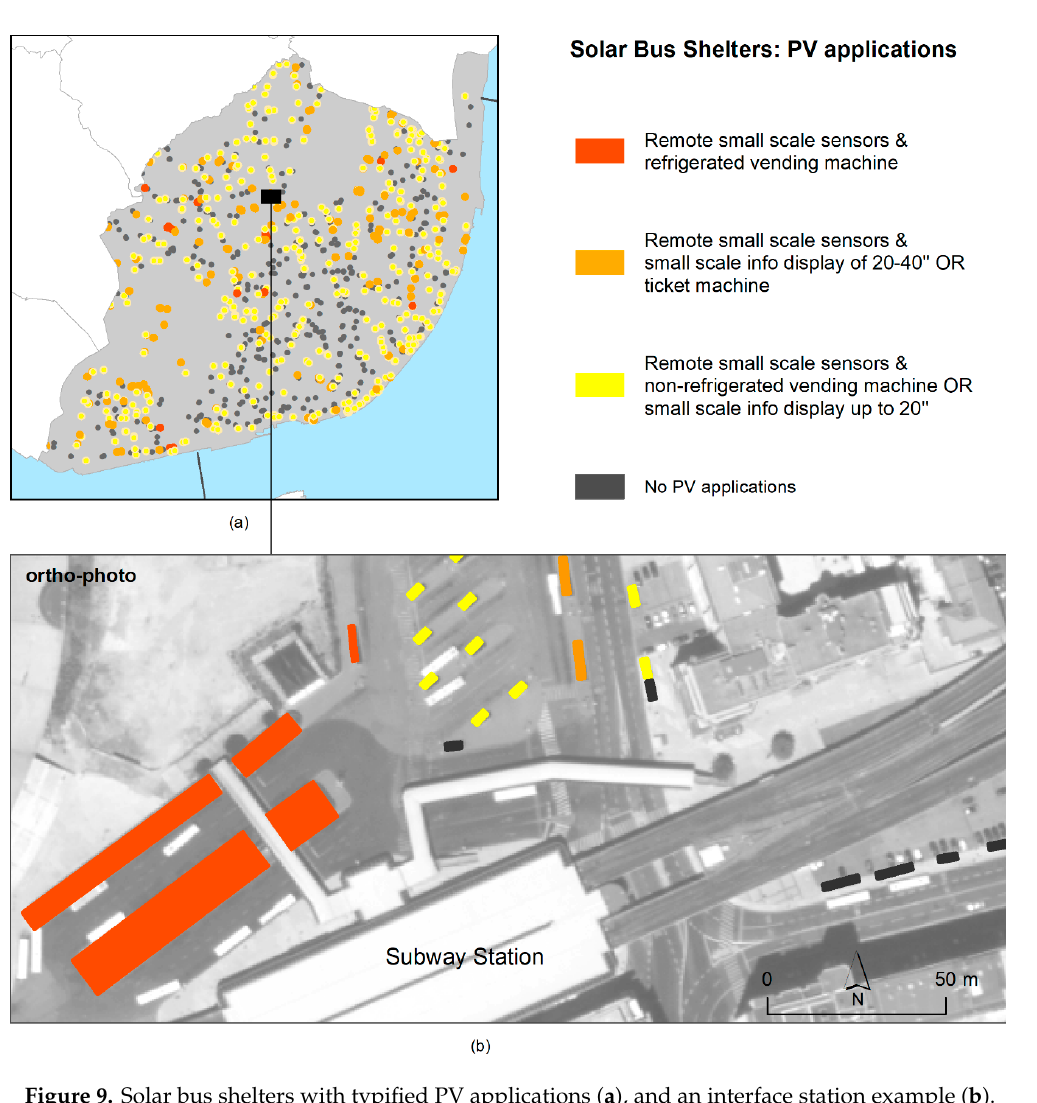
Table 2. Solar bus shelters suitable for PV-typified applications.